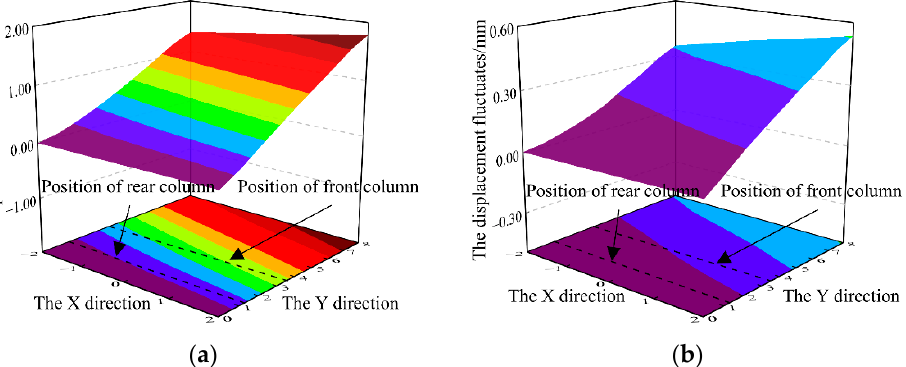
Figure 6. ( a ) Vertical displacement fluctuation of the hinge point of the front column. ( b ) Vertical displacement fluctuation of the hinge point of the rear column. displacement fluctuation of the hinge point of the rear